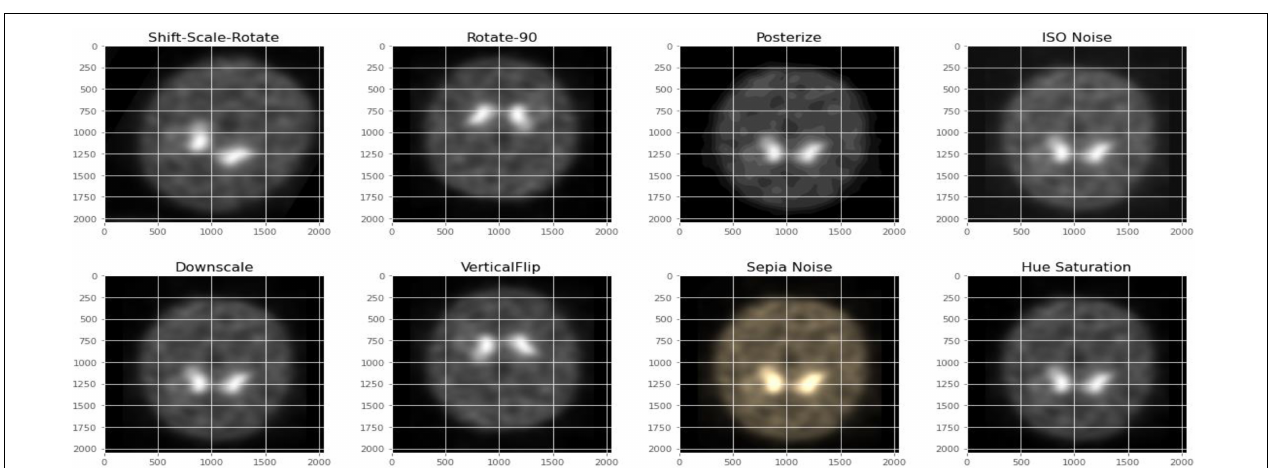
FIGURE 1 | Edge detection (A) healthy subject (B) PD subject.